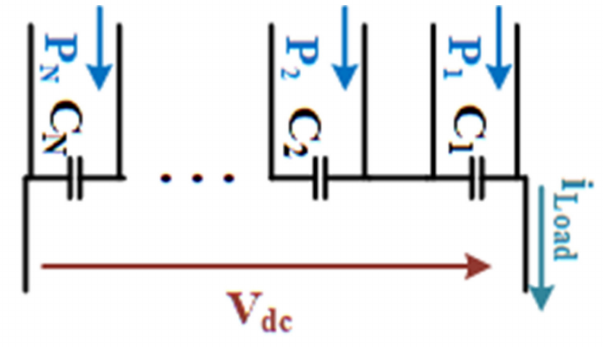
Figure 2. Cascade topology with di ff erent injected powers by